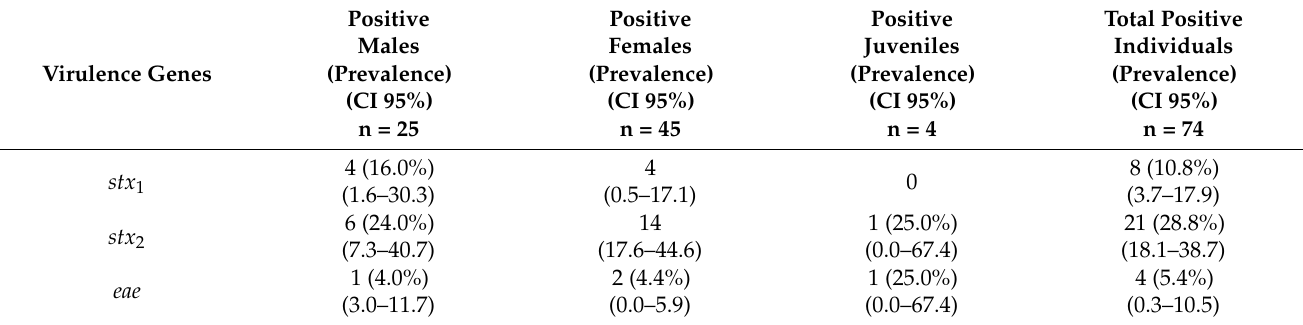
Table 3. Prevalence of enteropathogenic E. coli detected in Anolis sp. from Tenerife, Canary